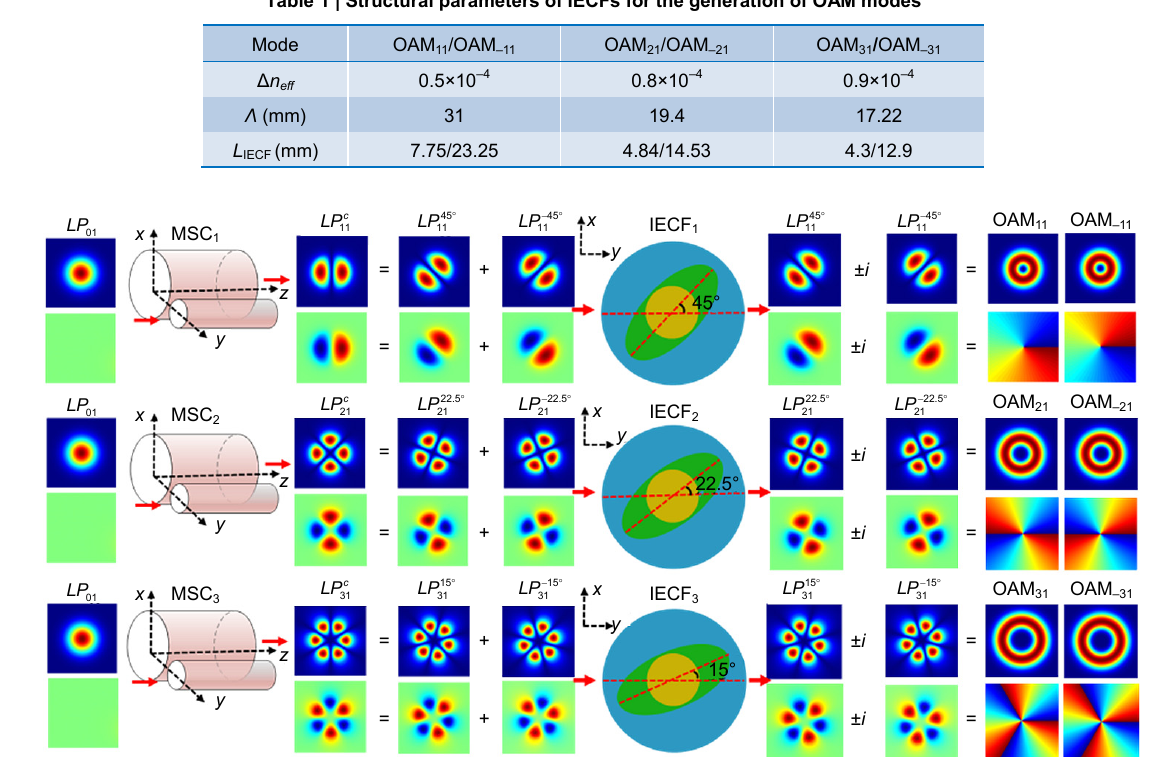
mode to the c LP , and c LP modes by coupling in the designed 21 31 01 , c LP , and c LP modes to the OAM ±11 , OAM ±21 , and OAM ±31 modes after passing through the designed 11 21 21